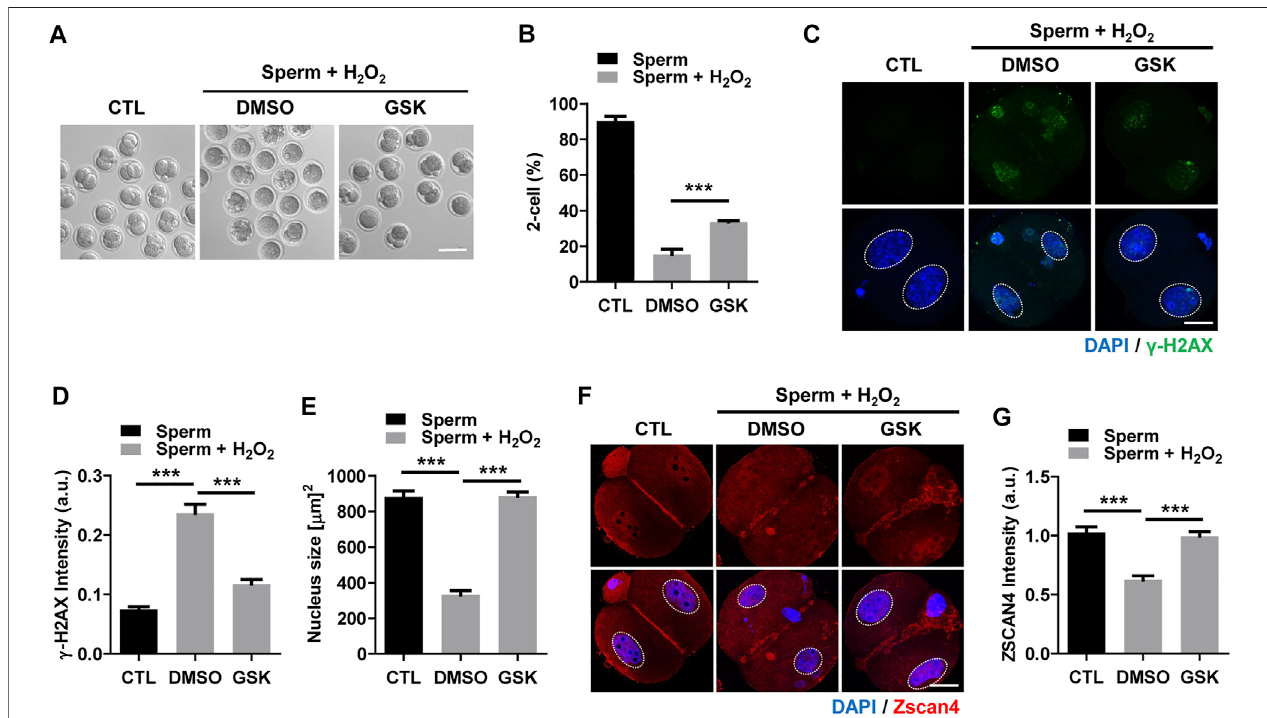
FIGURE 3 | WIP1 inhibition improves two-cell development and zygotic genome activation. (A,B) The rate of two-cell embryos was shown with representative images at 24 h after ICSI. Scale bar, 100 μ m. (C – E) The γ -H2AX intensity and nuclear size were quanti fi ed and shown with representative images. Scale bar, 20 μ m. (F,G) The Zscan4 intensity was quanti fi ed and shown with representative images. Scale bar, 20 μ m.